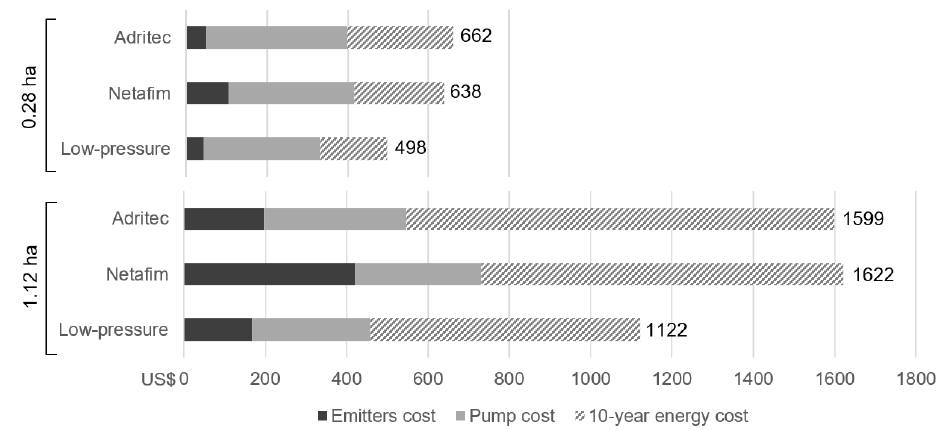
Figure 9. Capital costs for three emitter types, for the pumps required to operate each emitter type above its MCIP, and pumping electricity costs (using the Jordan tariff) for a 10-year operational period. Results are shown for the example plot (0.28 ha, pomegranate crop, 700 emitters with 8 L/h rated flow rate) and for a larger 1.12-ha farm with four plots of that size, irrigated in sequence.